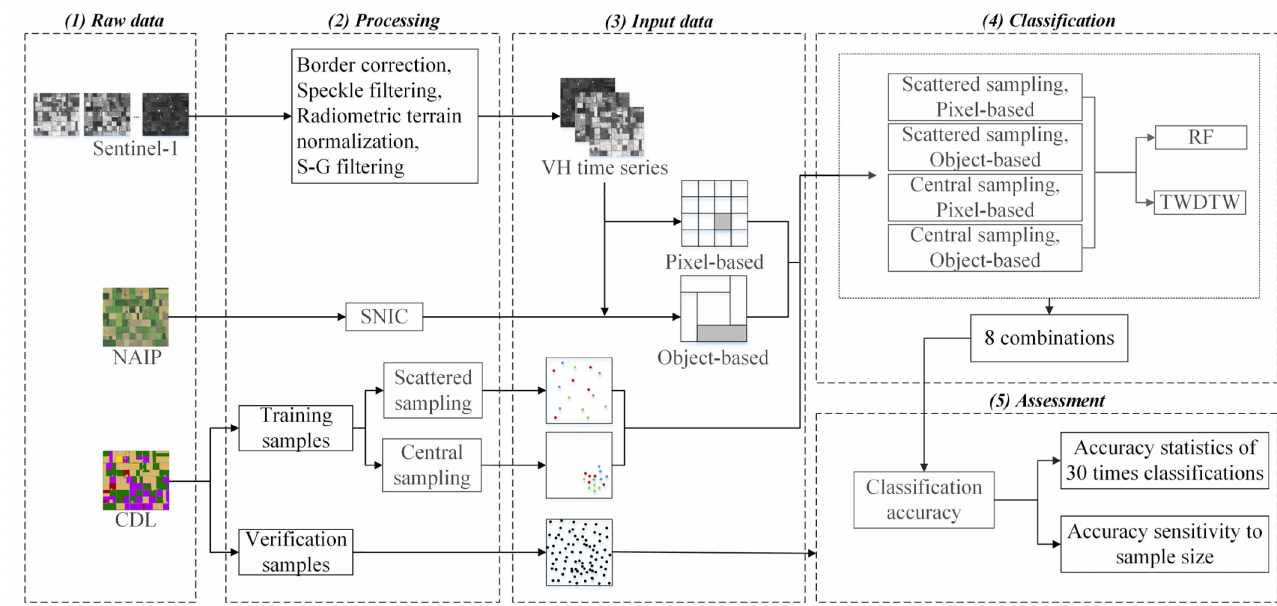
Figure 3. Methodological framework for crop type